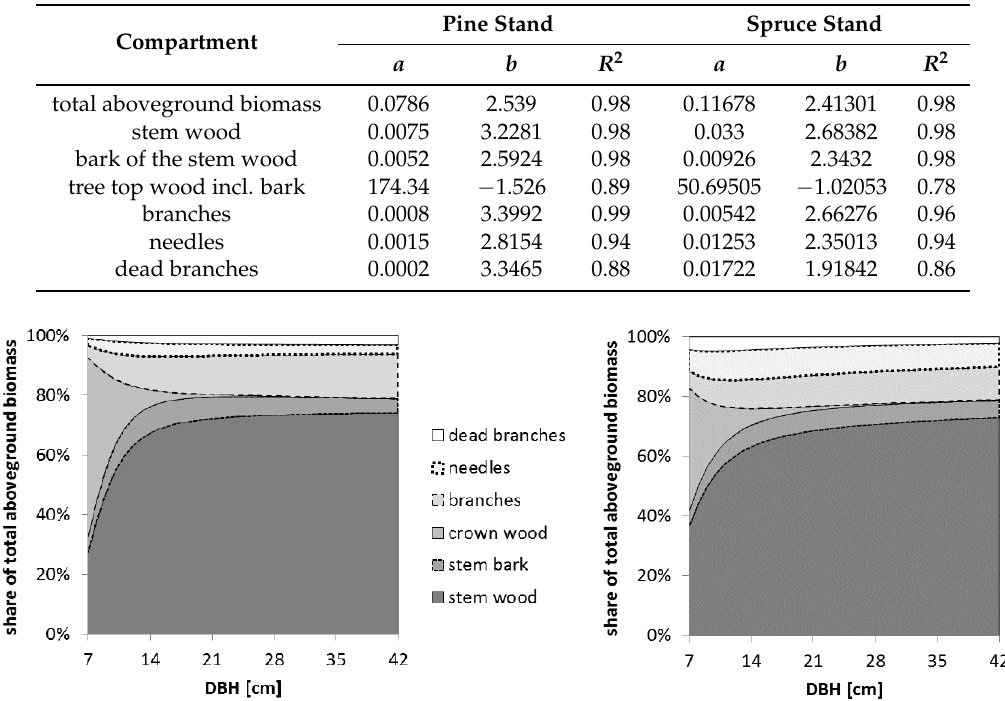
Figure 2. Relation of total aboveground biomass of the sampled spruce trees to DBH and biomass equation. Table 4. Equation coefficients (a, b) and coefficients of determination (R 2 ) of the biomass equations M bc = a × DBH ( cm ) b for the aboveground biomass compartments of the pine and spruce stand.